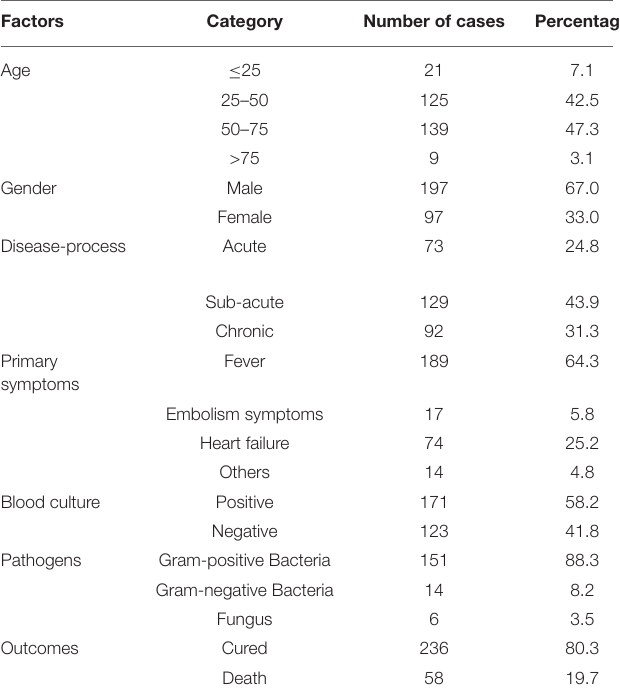
TABLE 1 | Baseline data of the study